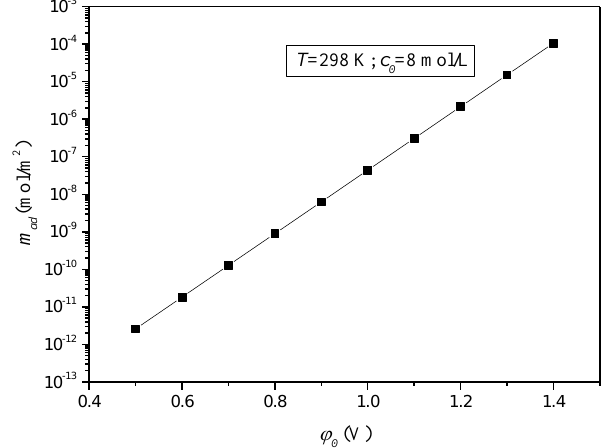
Figure 6. Adsorption capacity variation with different potentials.